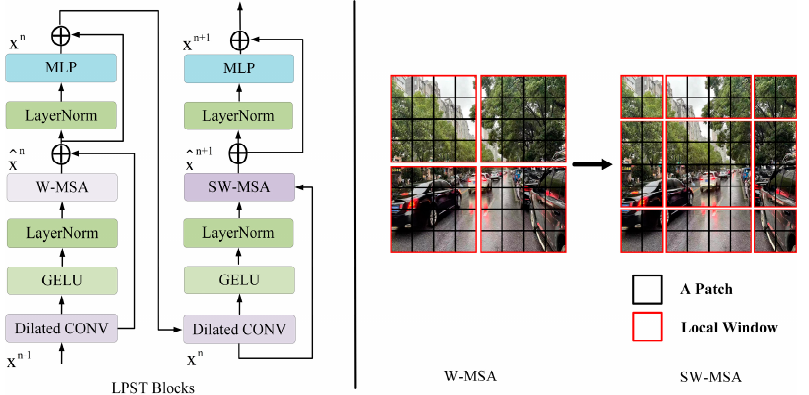
Figure 5. An illustration of the local perception Swin Transformer (LPST) block. W-MSA and SW-MSA are multi-head self-attention modules with regular and shifted windowing configurations, respectively.